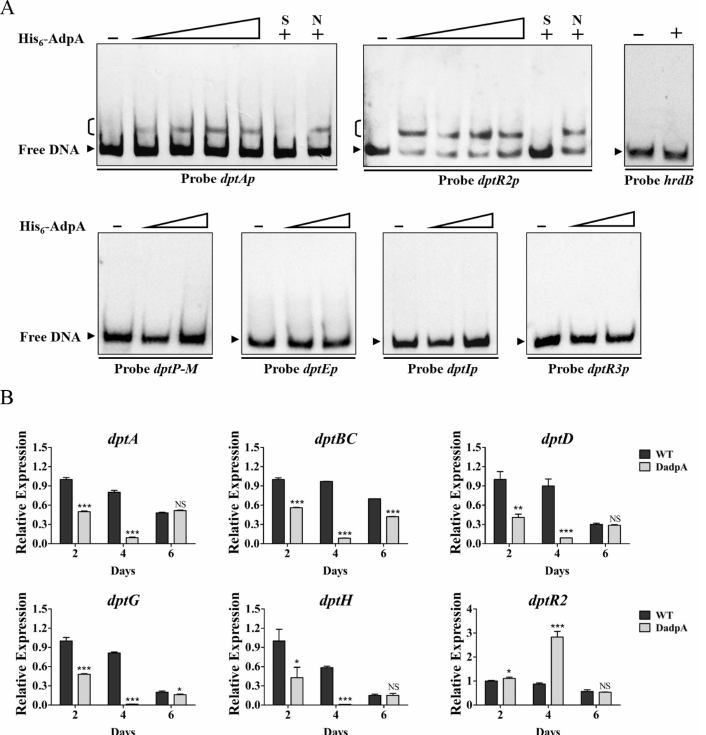
Figure 7. Identification of AdpA targets dptA and dptR2 . ( A ) EMSAs of His 6 -AdpA with indi- cated promoter probes. Concentrations of His 6 -AdpA for probes dptAp and dptR2p : 50, 100, 150, and 200 nM; for control probe hrdB : 200 nM; for other probes: 50 and 200 nM. A measure of 200